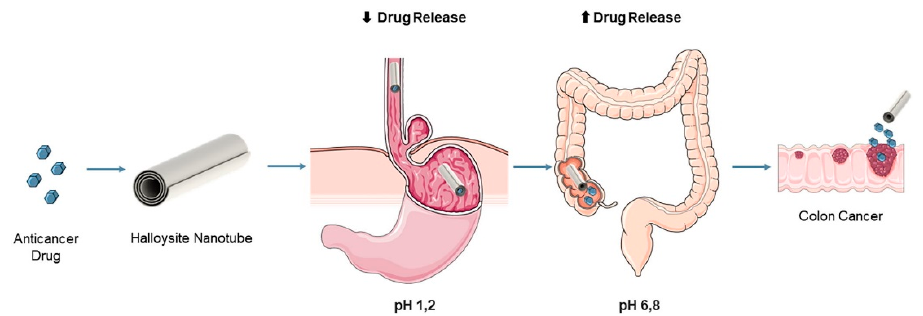
Figure 3. Schematic illustration of a pH-responsive nanoclay system for anticancer drug delivery to the intestines, avoiding early release in the stomach. Reprinted with permission from [9]. Copyright 2021 Elsevier